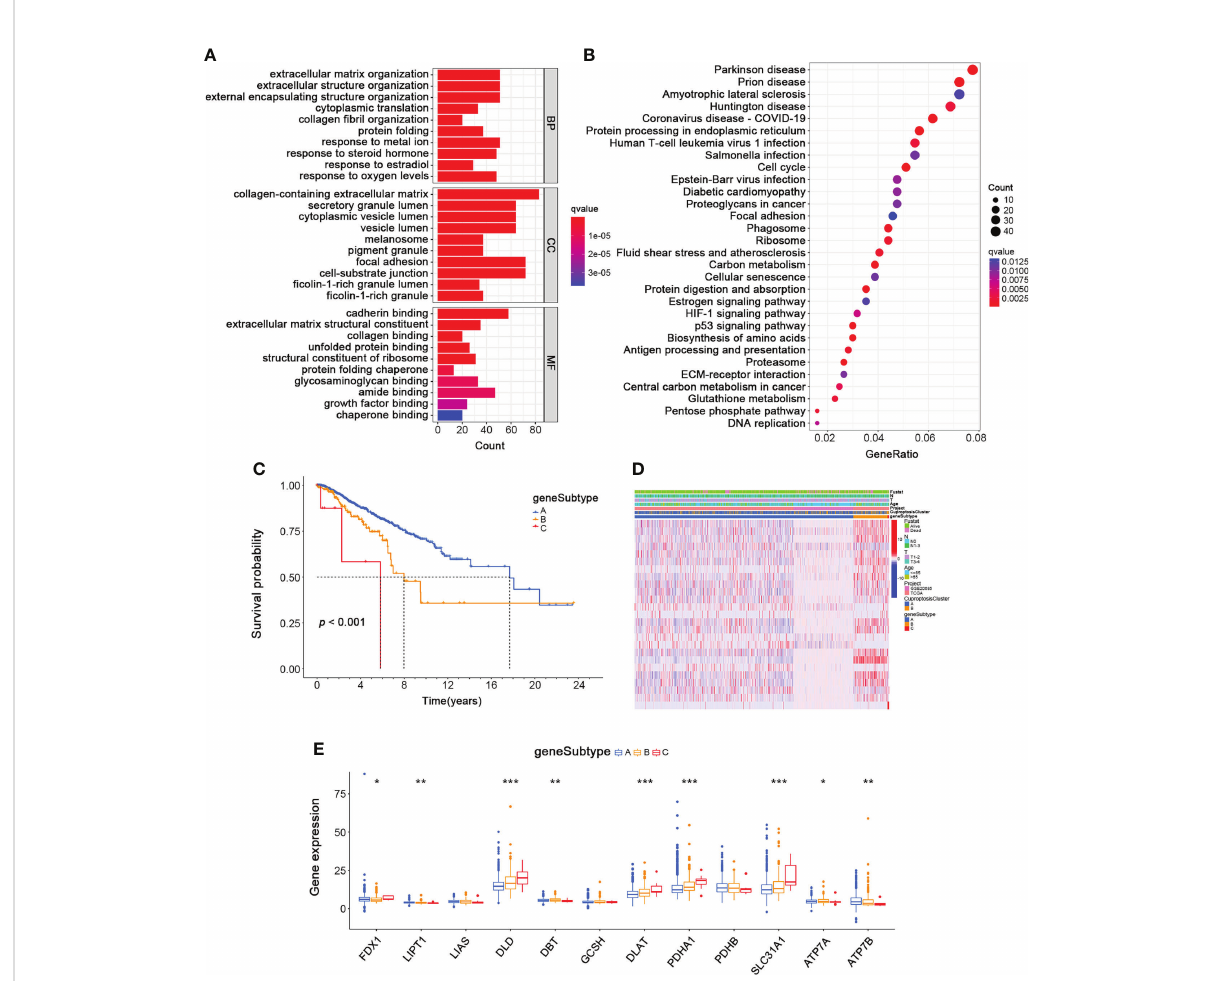
FIGURE 5 Identi fi cation of Gene Subtypes based on CuproptosisClusters of BRCA. (A, B) The GO and KEGG enrichment analyses of DEGs among the two CuproptosisClusters. (C) The overall survival of the three gene subtypes (Log-rank test). (D) The heatmap for the connections between clinicopathologic features and the three gene subtypes (blue: low expression; red: high expression). (E) The differences in the expression of 12 cuproptosis-related genes among the three gene subtypes (Wilcoxon test). DEGs, differentially expressed genes; GO, Gene Ontology; KEGG, Kyoto Encyclopedia of Genes and Genomes. * p < 0.05, ** p < 0.01, *** p <